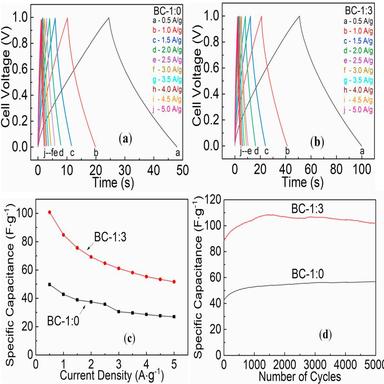
Galvanostatic characterization of the symmetric supercapacitor fabricated using (a) intrinsic and (b) nitrogen doped DDGS biocarbon materials, chargedischarge pattern for various specific currents, (c) specific capacity for various current density and (d) cycling performance.